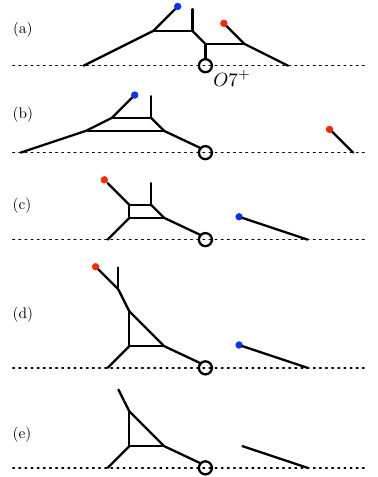
Figure 9. (a) A 5-brane web for SU(2) π +1 Adj . (b) An equivalent 5-brane web for SU(2) π +1 Adj where the D5 brane located on the right hand side of an O 7 + -plane in figure (a) is moved to the left hand side. (c) Hanany-Witten transition associated with the (1,1) 7-brane painted in blue in figure (b), going through the cut of the O 7 + -plane. (d) A flop transition. (e) Decoupling the flopped ‘instantonic’ hypermultiplet, giving rise to a 5-brane web for the local P 2 + “1 Adj ” theory. Clearly